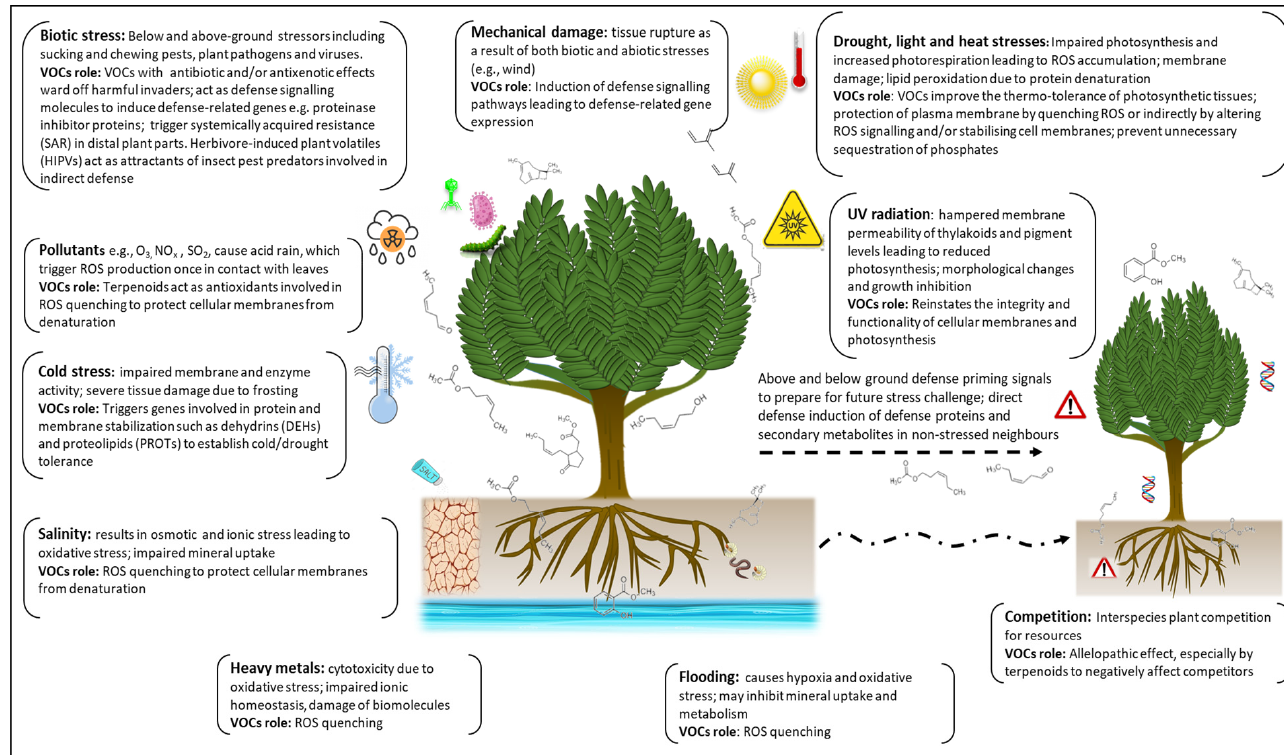
Figure 4. Role and mechanism of action of stress-induced volatile organic compounds (VOCs). In response to both biotic and abiotic stresses, VOCs induce various defence-signalling pathways and are involved in intra- and inter-plant priming against future stress challenges. The antixenotic and antibiotic effects of VOCs facilitate direct and indirect defence responses against biotic stressors. Both abiotic and biotic stress induce the production of reactive oxygen species (ROS) whose negative oxidative effects are curbed by VOCs through ROS quenching and cell membrane stabilisation. Thermo-tolerance of photosynthetic tissue is also facilitated by some VOCs under high temperature conditions. (Modified from Vickers et al. [208]). Table 1. Volatile-mediated priming in plant–plant communication under biotic and abiotic stress conditions.